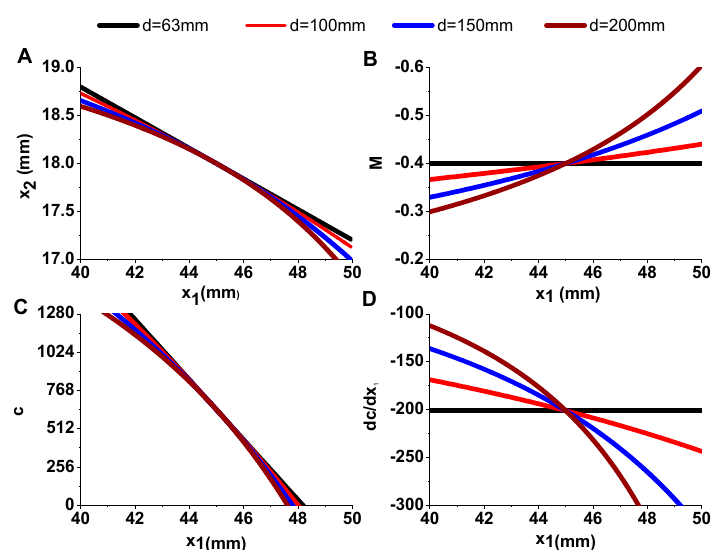
Figure 7. Simulation results with conditions of d = 63 mm ( F 1 + F 2 ) , 100 mm, 150 mm, and 200 mm. ( A ) The changes of distance from image plane to optical lens II ( x 2 ). ( B ) Magnification of optical system ( M ). ( C ) Position of stripe in the captured image ( c ). ( D ) Measurement sensitivity ( dc / dx 1 ) with respect to distance from specimen to optical lens I ( x 1